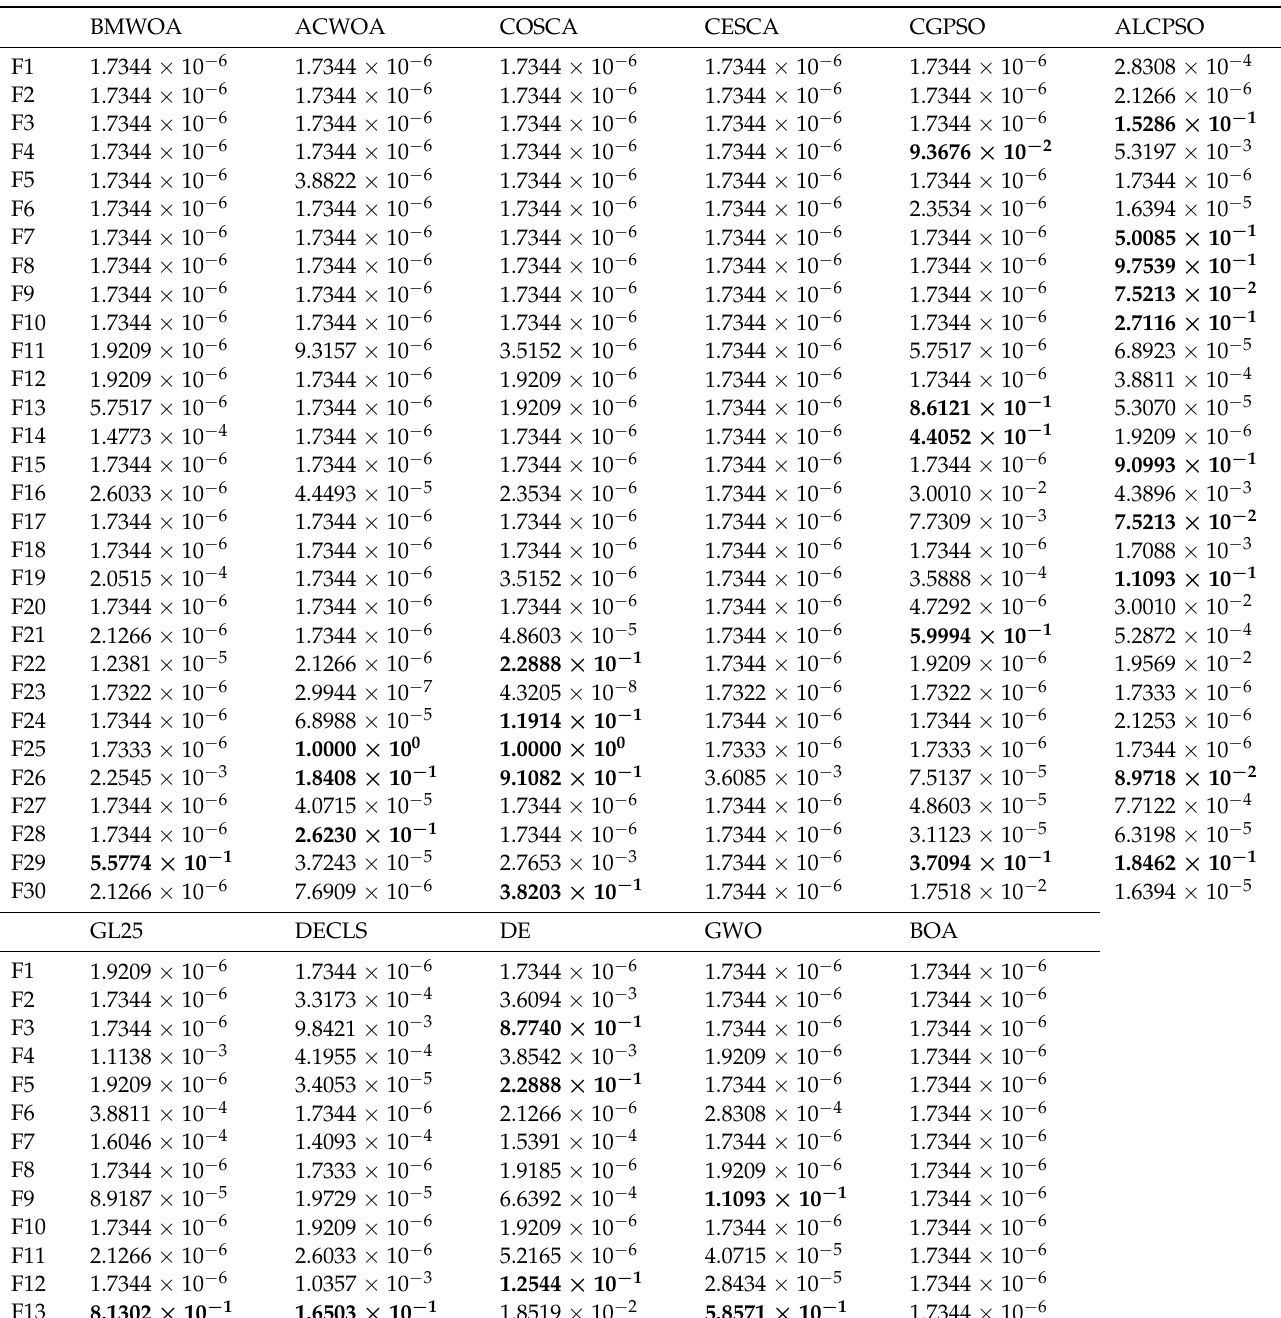
Table A3. The p -value of CBBOA versus other